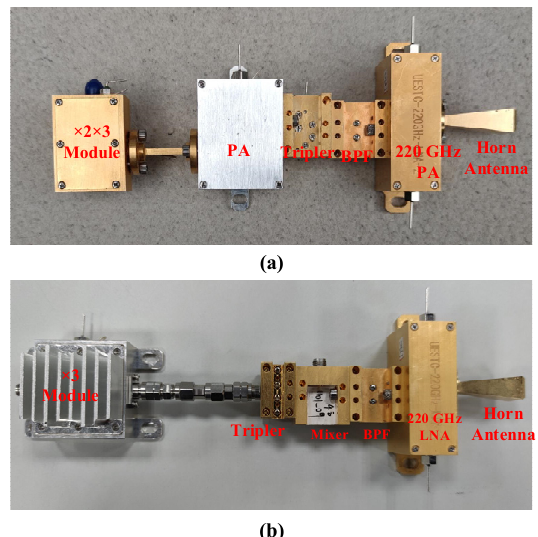
Figure 19. Photograph of the fabricated 200–240 GHz remote sensing system for imaging applications: ( a ) transmitter channel; ( b ) receiver channel.